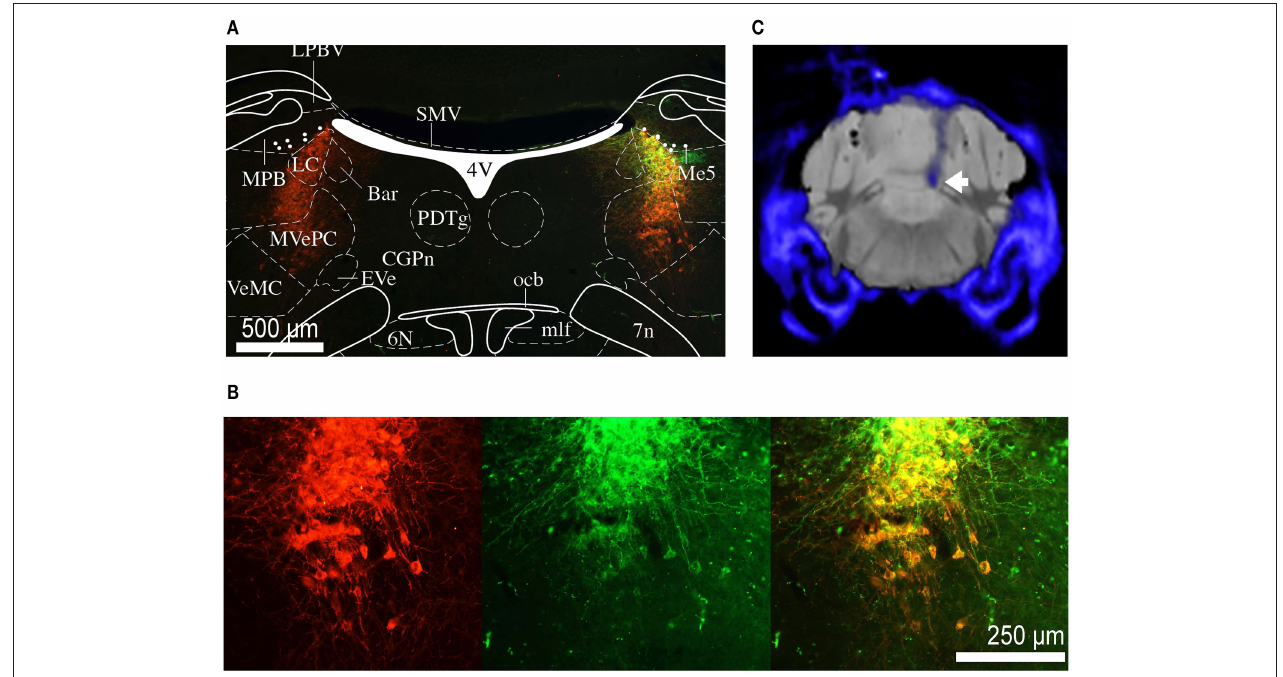
FIGURE 2 | Histology and micro CT. (A) Section of the brain at the level of the LC. Red staining indicates TH positive neurons, green staining indicates eNpHR 3.0 opsin expression (through eYFP reporter). Depending on the level of opsin expression, the color if individual cells co-expressing TH and eNpHR 3.0 varies from orange to yellow. The overlaid atlas ( Paxinos and Franklin, 2012) picture demonstrates that expression is restricted to the noradrenergic cells of LC. Labeled cell bodies outside the LC were not observed. (B) Magnified image of (A) showing co-labeling of TH (red) and eNpHR-eYFP (green). Scale bar: 500 µ m. (C) Group average micro CT image of skull and fiber (blue) overlaid on standard mouse MRI dataset (gray). The tip of the fiber is placed directly above the LC (white arrow).